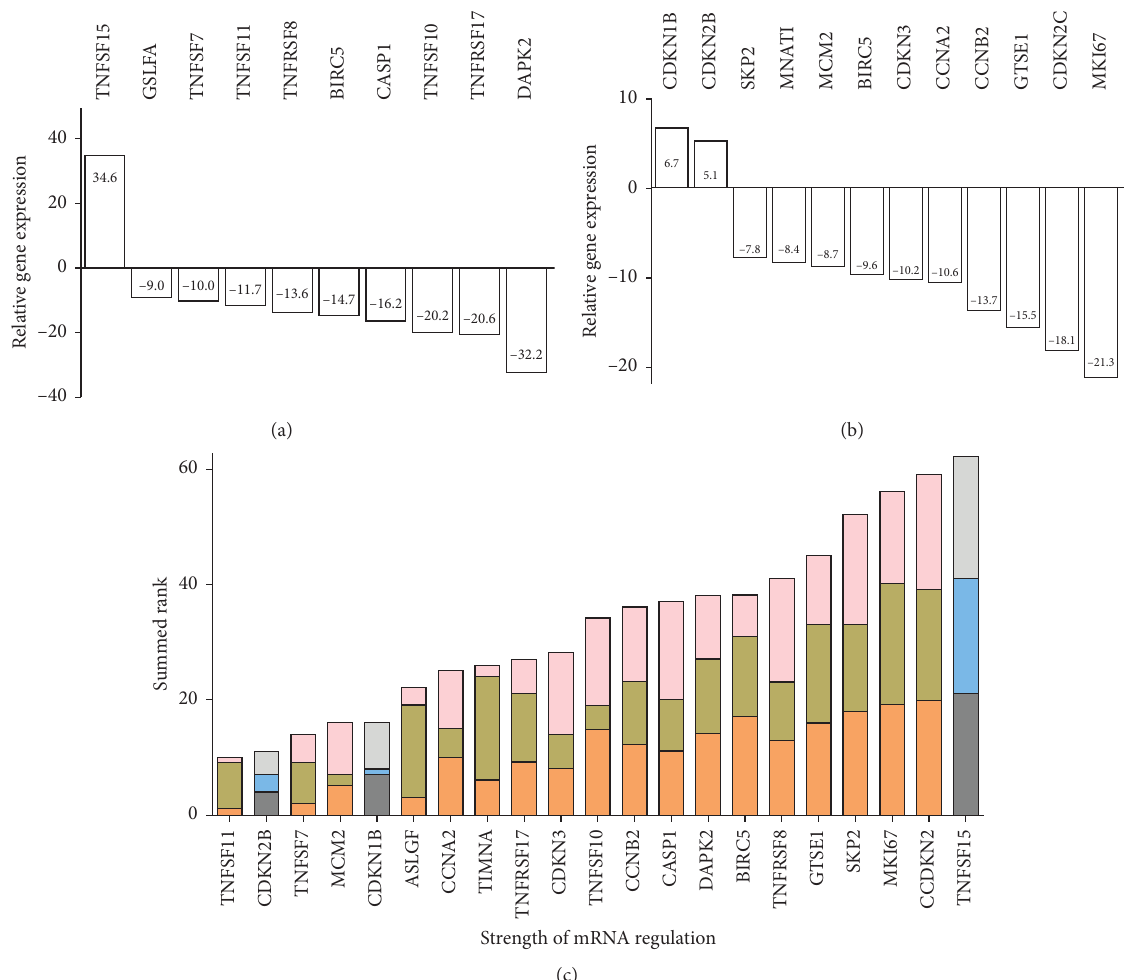
Figure 2: mRNA-expression levels of genes related to apoptosis and cell-cycle progression in HepG2 cells. (a, b) Cutoff values of ≥ +5 and ≤ − 7.5 were determined, which resulted in the selection of 21 out of 88 analysed genes. These most dysregulated genes associated with cell- cycle progression and apoptosis were selected for further validation. BIRC5 expression was included in both arrays. Genes whose relative mRNA-expression levels could not be evaluated (due to no detectable amplification) were excluded from the analysis. (c) The relative mRNA-expression levels of the selected 21 genes were analysed in three independent experiments performed with HepG2 cells treated with I-ol (100 μ M) for 48h. The expression level of each gene was ranked, where the highest expression levels corresponded with the highest rank. Finally, the sums of all three ranking values were calculated for each gene and are depicted as stacked columns. In concrete terms, this ranking indicated that TNFSF11 was the least expressed gene and that TNFSF15 the most expressed gene. Three differentially expressed genes (TNFSF15, CDKN1B, and CDKN2B) showed repressed mRNA expression compared to the control group treated with 100 μ M